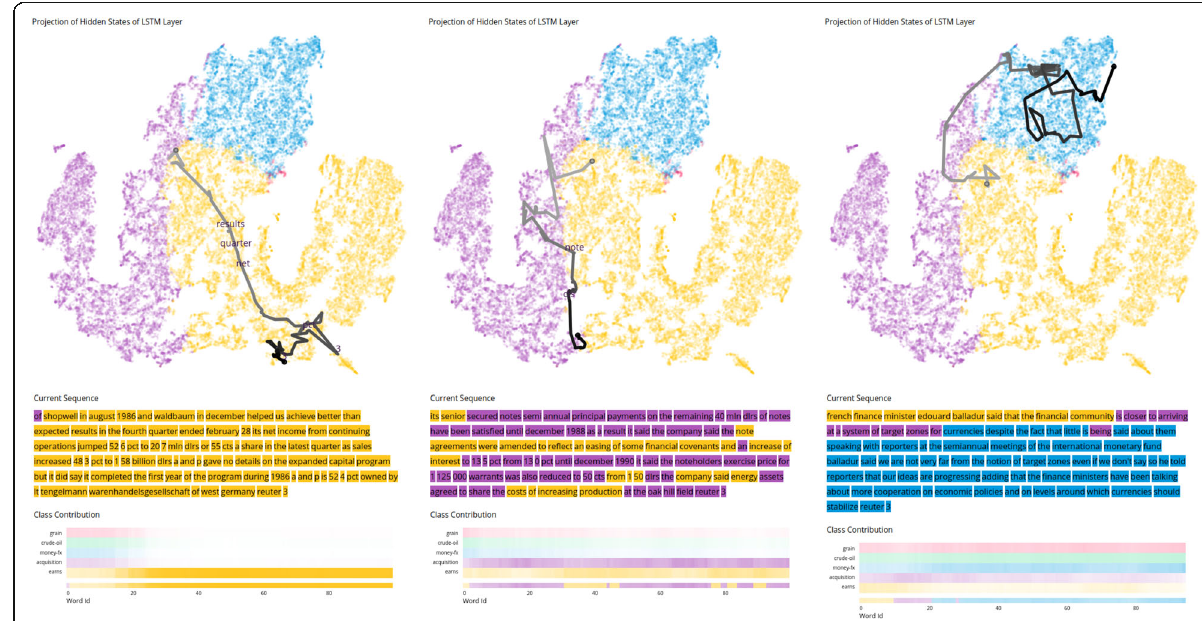
Fig. 7 Examples of correctly classified sequences in a model trained for multi-class classification. The projection provides insight into the class distribution within the hidden state space. The heatmap matrix supports the analysis by displaying the evolution of the EP over sequence processing. Hence, the user can better identify at which time steps the model was able to distinguish between classes. In the visualizations on the left, the model is certain for the classification of earns (yellow). In the visualizations in the middle, the model is uncertain between earns (yellow) and acquisition (violet), and both classes have a similar EP while processing the sequence. In the visualizations on the right, the model is uncertain among all five classes and the EP for money-fx (blue) is only slightly larger compared to the other classes. Similar cases are likely to be misclassified. Underlying data source: Reuters